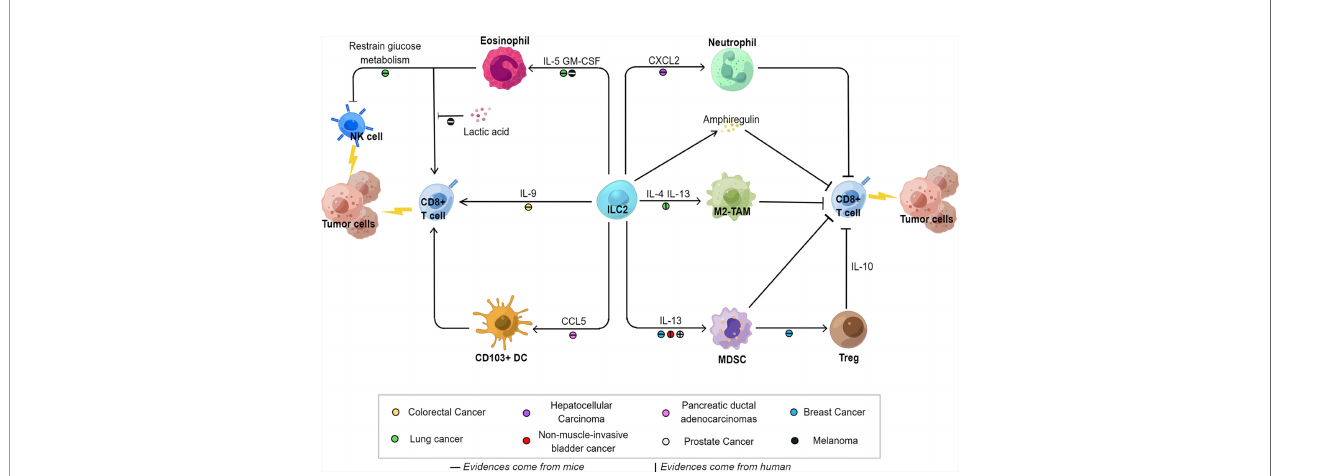
FIGURE 1 | The regulatory network of ILC2s in the tumor microenvironment. In fl uenced by the local microenvironment, ILC2s exist the signal and functional cross- talk with other immune cells and exhibit inhibitory (left) or facilitating (right) effects on tumors. A regulatory network is formed centered on ILC2s, which act as a crucial regulator in tumor immunity. Speci fi c tumor types associated with each pathway have been marked with colorful spots. M2-TAM M2 tumor-associated macrophages, MDSC myeloid-derived suppressor cells, GM-CSF granulocyte macrophage colony-stimulating factor, CXCL2 C-X-C motif chemokine ligand 2, CCL5 C-C motif chemokine ligand